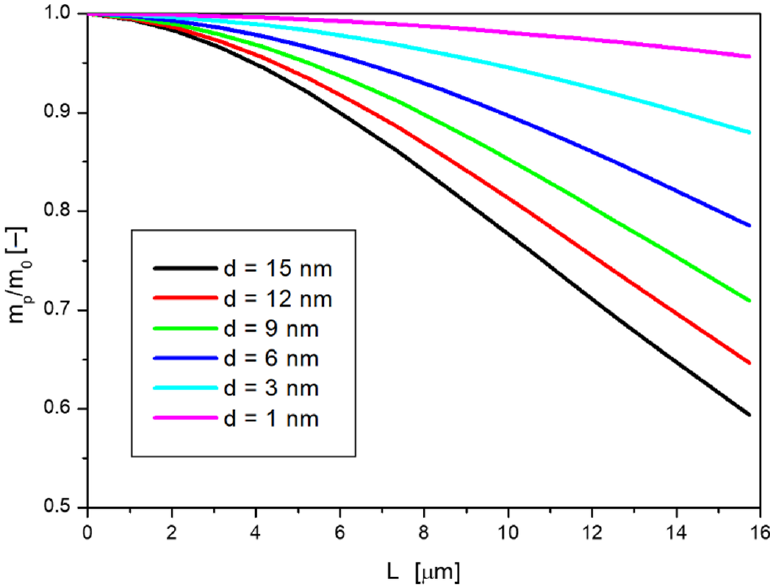
Figure 7. Dependence of dimensionless nanoparticle mass on skin film thickness for different particle diameters.